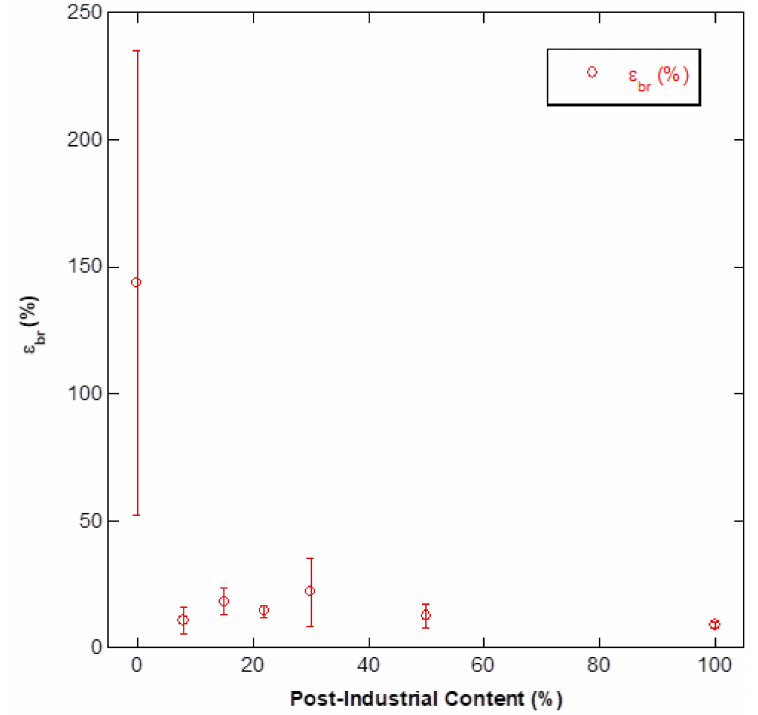
Figure 11. Strain to breaking point versus content of post-industrial